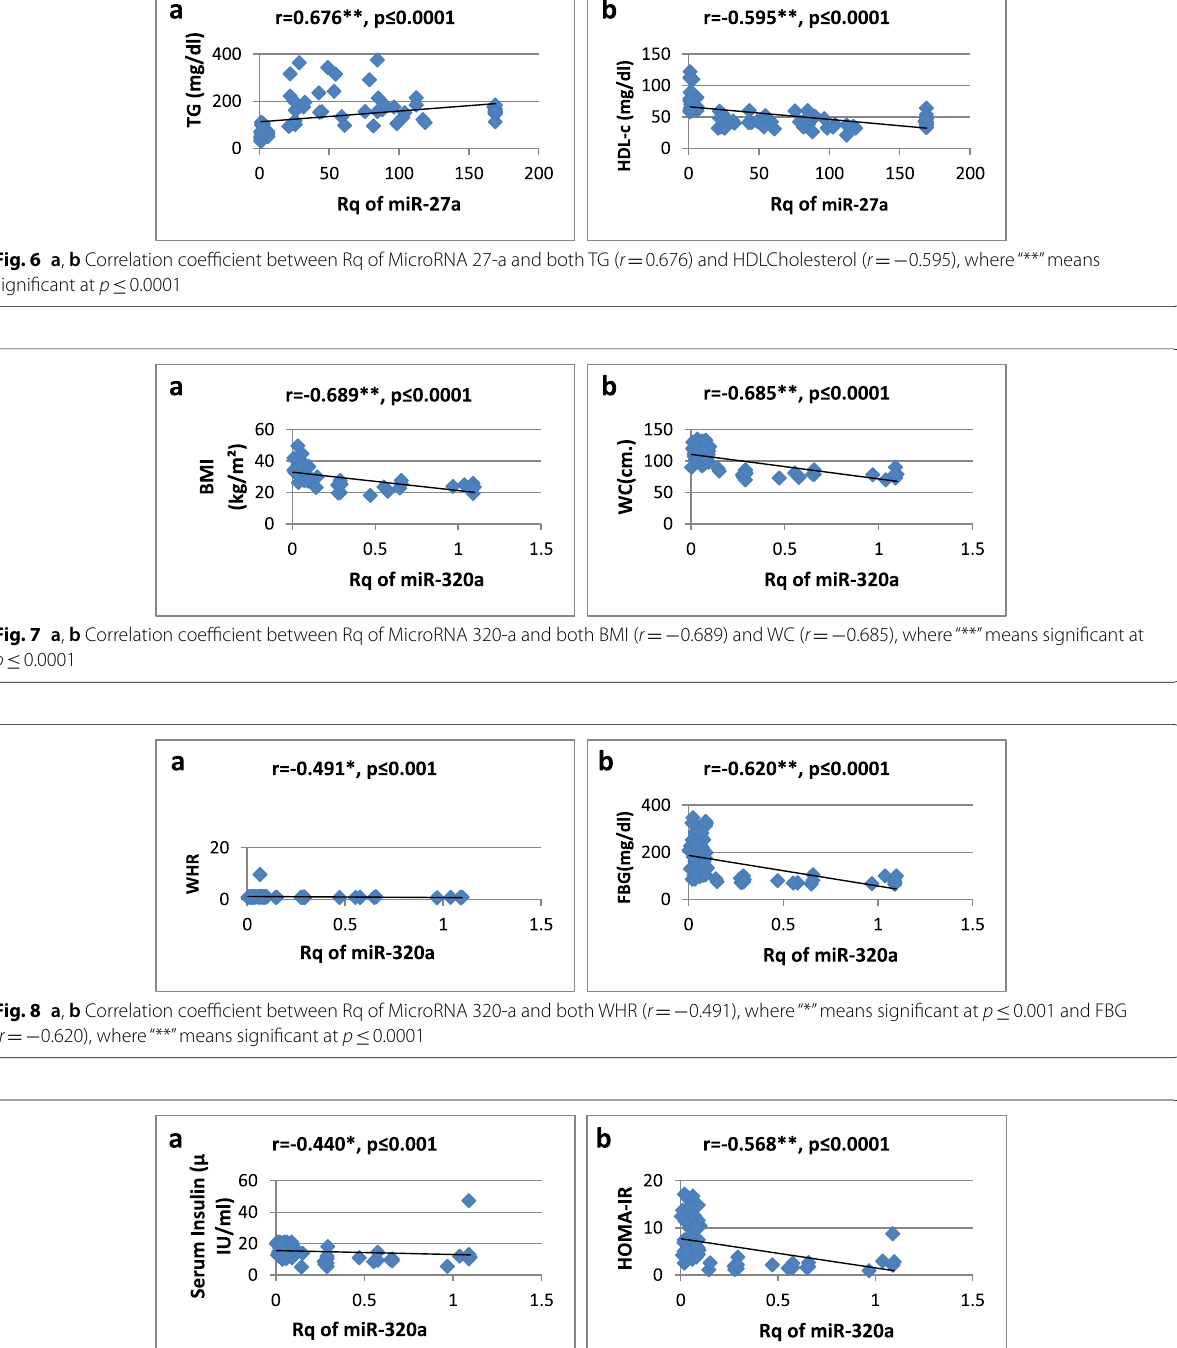
0.440), where “*” means significant at p = −